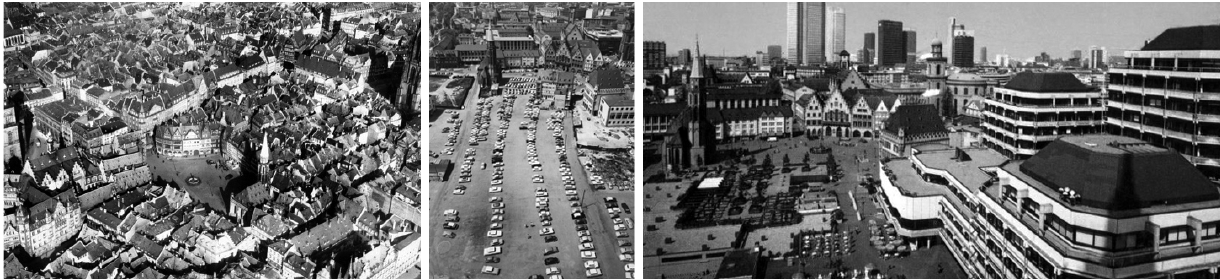
Figure 18. Frankfurt am Main: The old city. From left to right: Historical city center, Frankfurt am Main; Aerial view, 1936; Dom-Römerberg-Area, view from the Cathedral, 1961; the Technical Town Hall, 1985 ca. Source: Sturm & Cachola Schmal